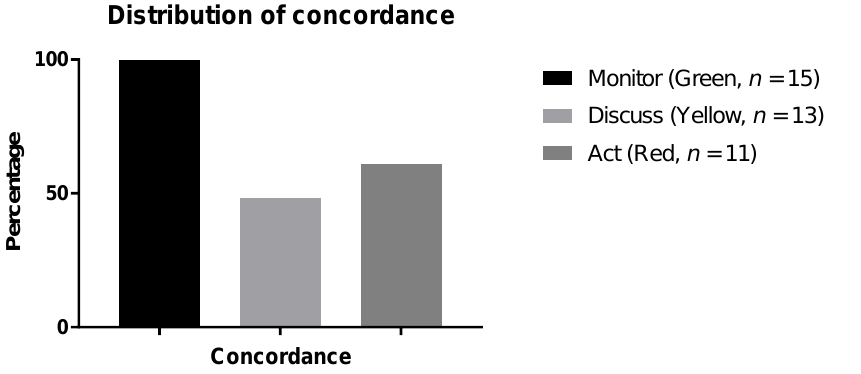
Figure 3. Distribution of concordance between MENTOR and clinician treatment assessment decision ( n = 60), total concordance ( n = 39).